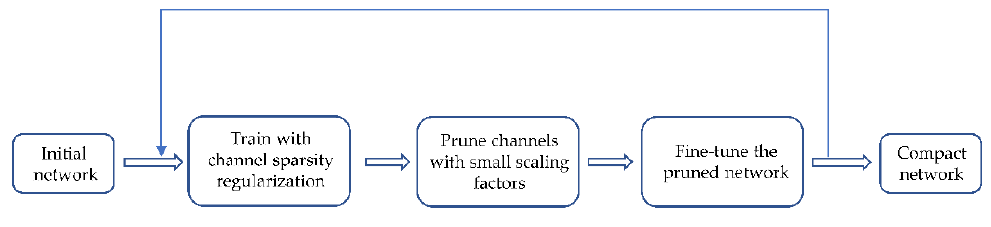
Figure 7. Process of pruning.